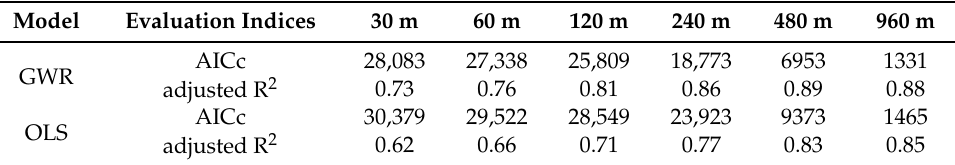
Table 4. Performance indicators of GWR and OLS models at different spatial